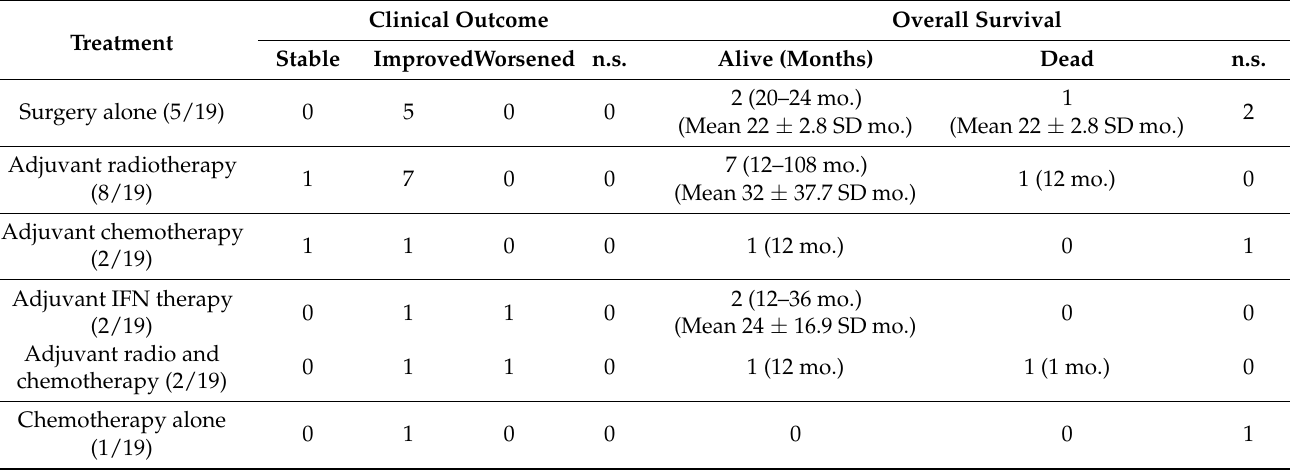
Table 4. Outcome and overall survival data according to the treatment in 19 intradural extramedullary spinal metastases from RCC.